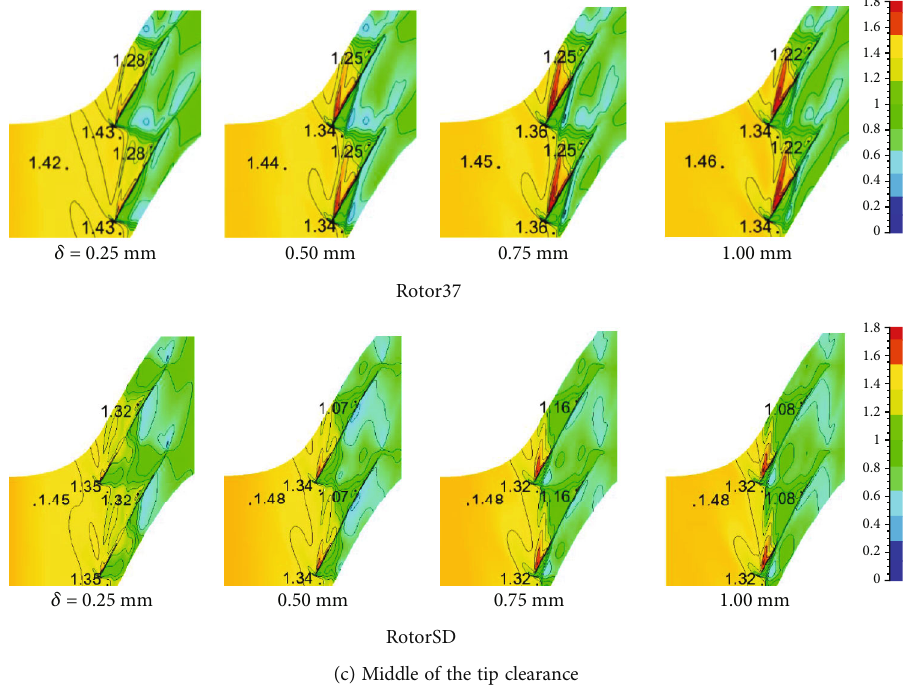
Figure 12: Contours of the relative Mach number.